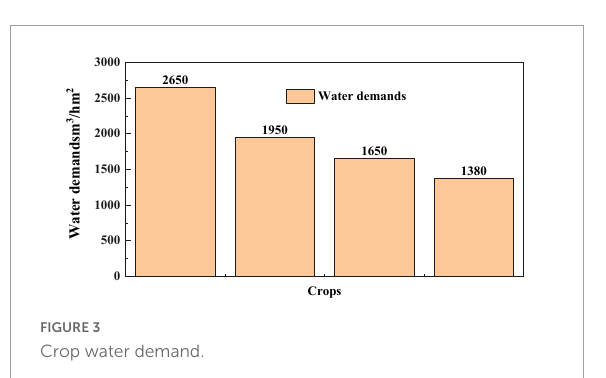
FIGURE4 Crop fertilizer demand.